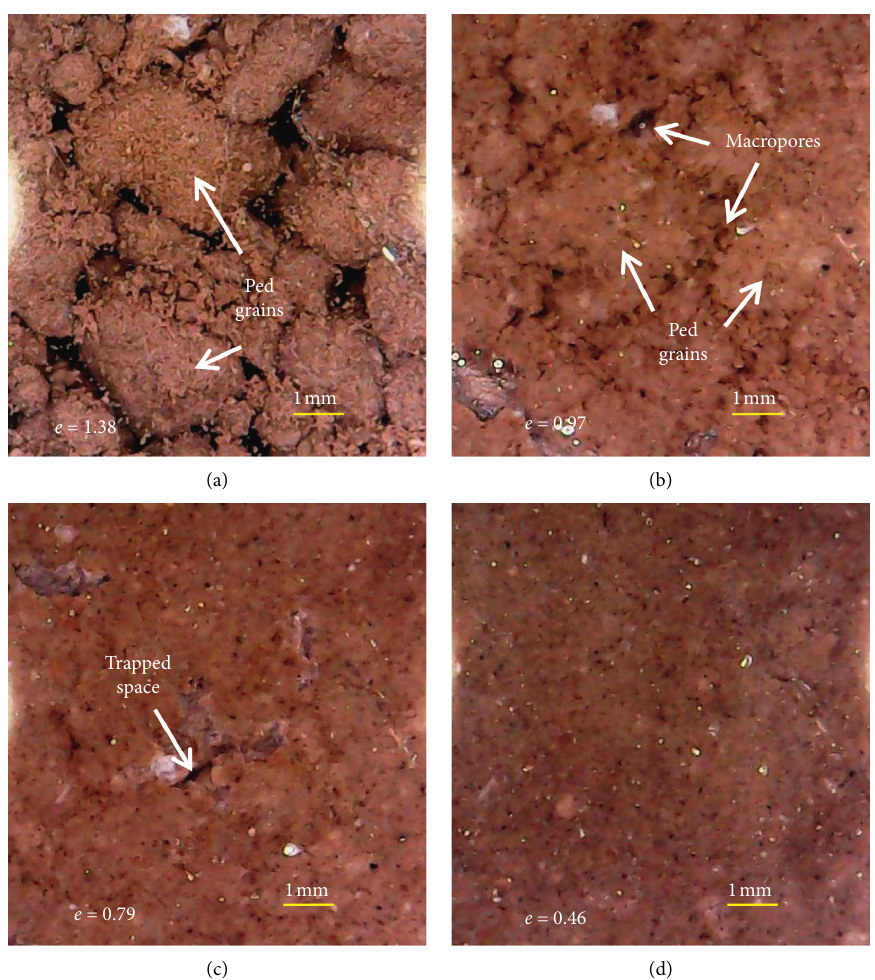
Figure 7: Evolution of soil structure during one-dimensionally compression of sample Ι